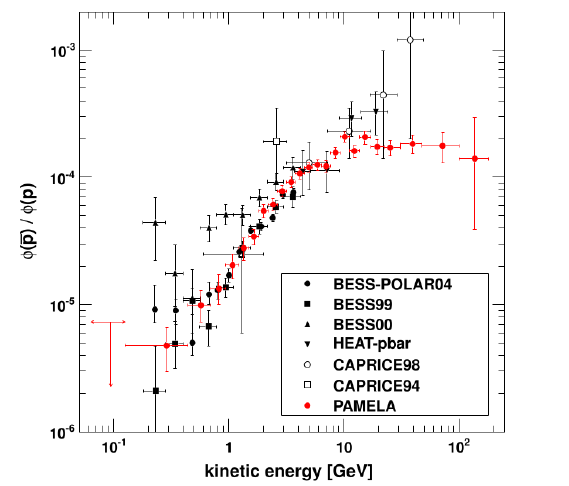
Figure 14. Anti-proton / proton ratio measured by several experi- ments